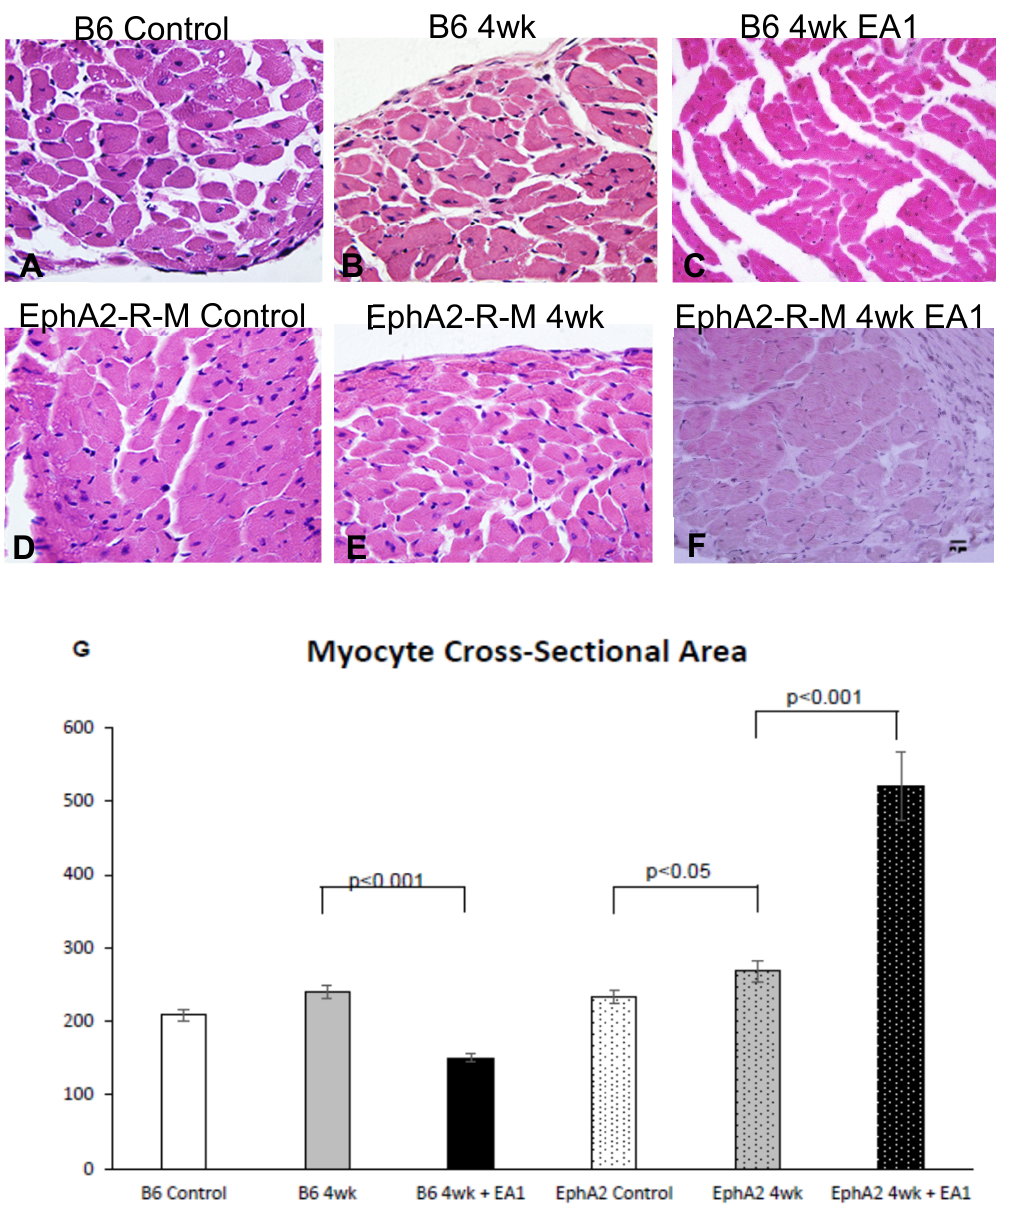
Figure 3. Myocyte Cross-Sectional Area in WT and EphA2-R-M Mouse Hearts. Myocyte cross-sectional area in WT and EphA2-R-M mice in uninjured control, untreated (IgG-Fc) vs. ephrinA1-Fc- treated mice at 4 weeks post-MI (stain: hematoxylin and eosin; 400 × ). Representative images in WT B6 ( A – C ) but not in EphA2-R-M ( D – F ) mouse hearts show that EA1 significantly attenuated compensatory hypertrophy ( G ), indicating that progression to the heart failure phenotype may be accelerated in mice deficient in EphA2-R. B6 WT control ( n = 10), EphA2-R-M control ( n = 10), WT B6 (IgG-Fc 4w, n = 8), EphA2-R-M (IgG-Fc, n = 10), EA1-treated WT B6 ( n = 11) and ephrinA1-Fc-treated EphA2-R-M ( n = 4).